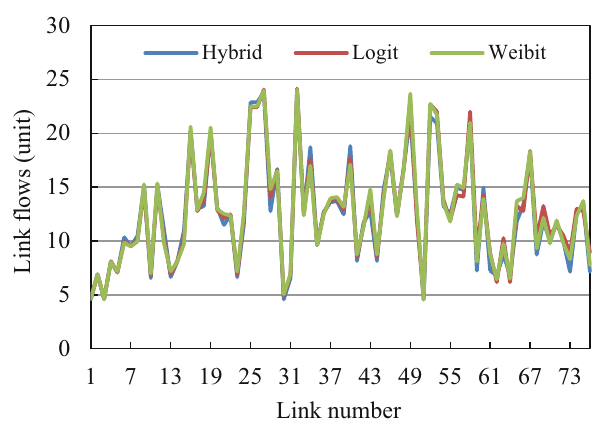
Fig. 5 Link flows assigned by the logit, weibit and hybrid models -2-1.5-1-0.500.511.52 Fig. 6 Absolute difference of link flows between logit/weibit and hybrid models